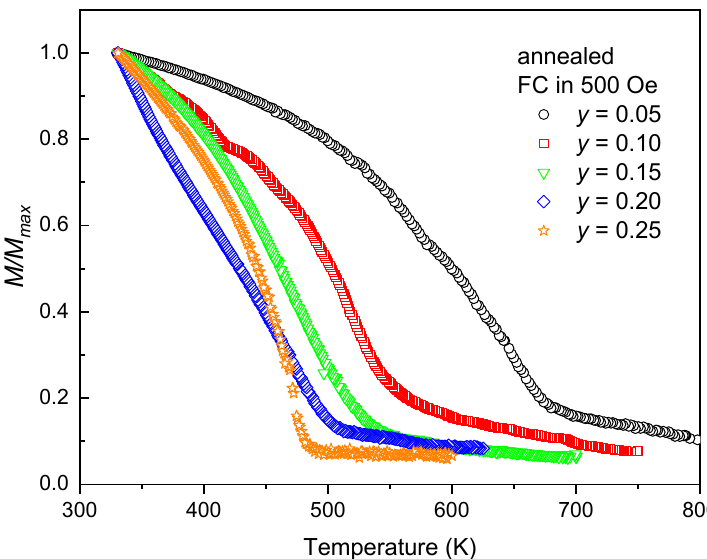
Figure 3. The normalized temperature-dependent magnetic moment of the annealed BiFe 1 − y [Zn 0.5 Ti 0.5 ] y O 3 samples measured in the FC regime in the temperature range above 330 K.